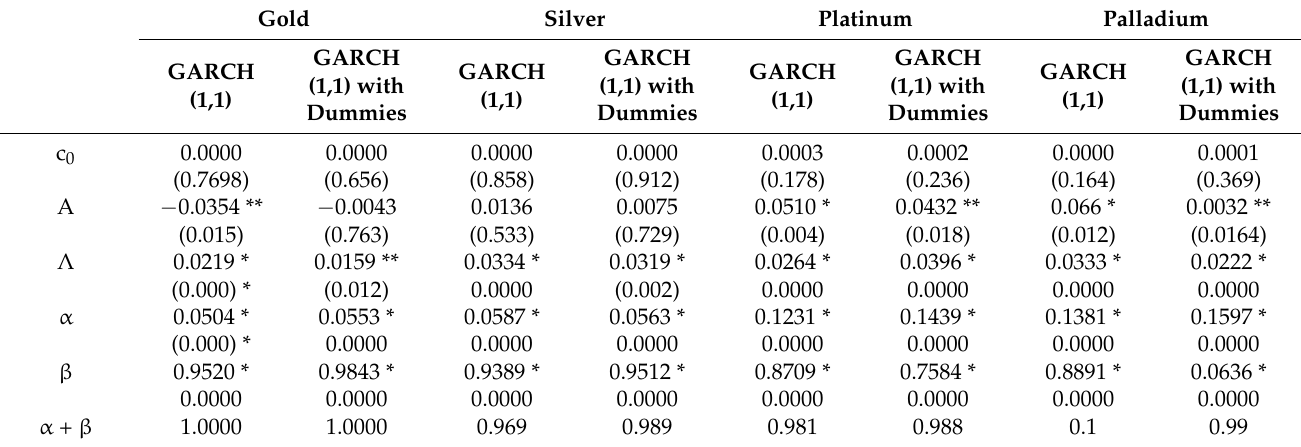
Table 1. Stability of precious metal prices under the influence of the Dow Jones industrial and structural shifts.